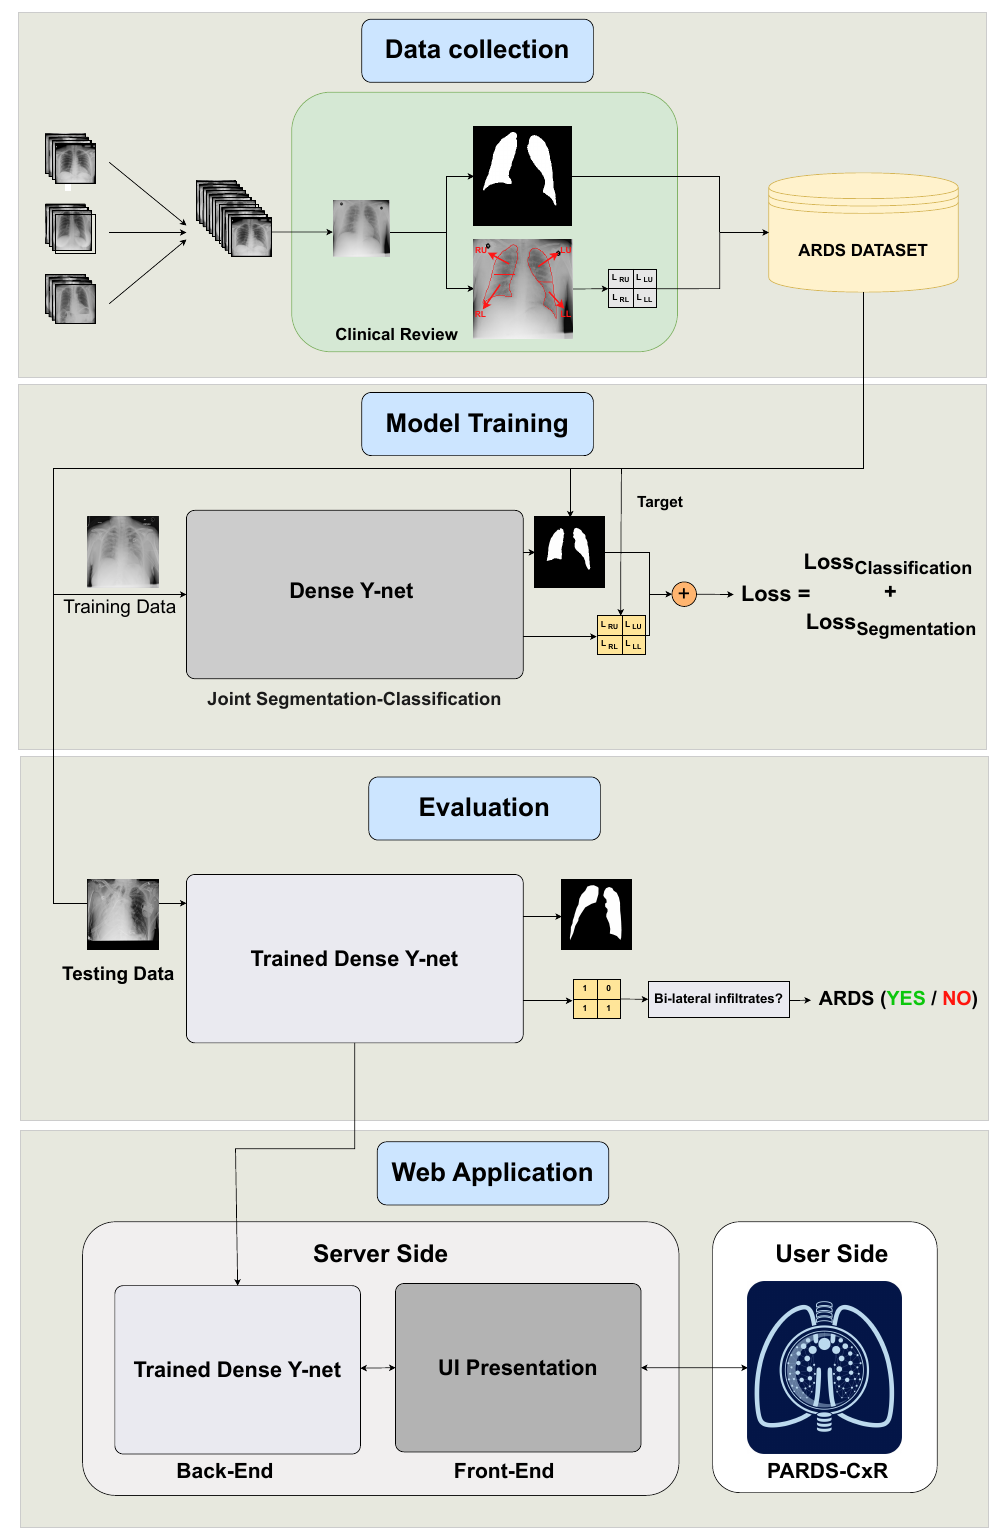
Figure 1. Organization of our study into four main phases. The data are collected from several data sources and annotated at Saint-Justine Hospital, Montreal, Canada. The DL model is trained using quadrant-level labels and lung segmentation maps. It is then evaluated on a set of previously unseen images; both the classification and segmentation performances are assessed. Finally, a web-based platform is designed and made available through the